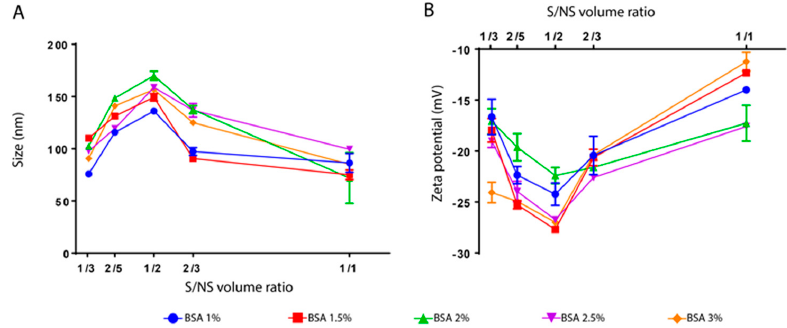
Figure 5. The size ( A ) and zeta potential ( B ) of BSA nanoparticles as a function of S/NS volume ratio at different BSA percentages (from 1 to 3%). Measurements were performed at room temperature with pH between 6.8 and 7. Measurements from separate assays were combined ( n = 6) and represented as mean ± SD.